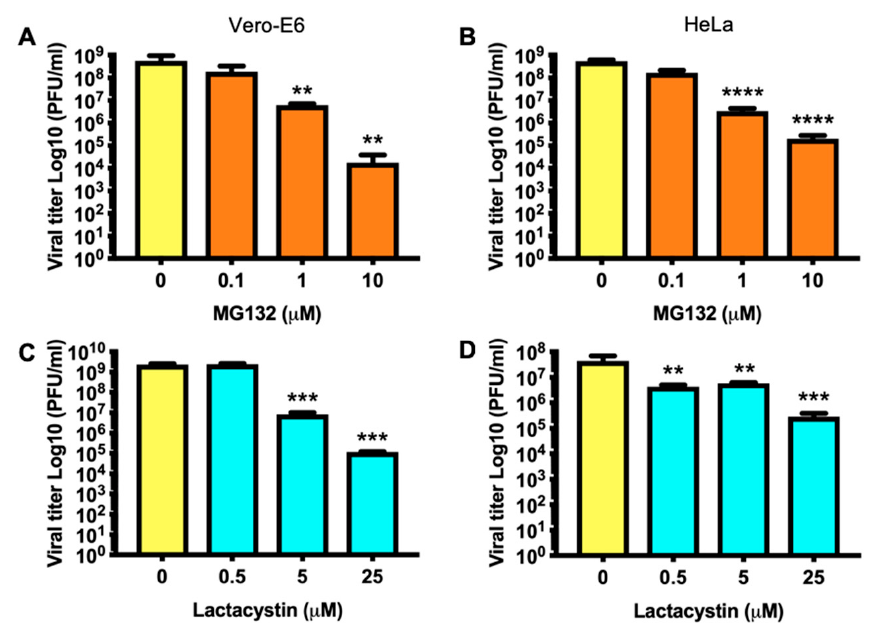
Figure 3. Proteasome inhibitors reduce MAYV progeny production in a concentration-dependent manner. Vero-E6 ( A , C ) or HeLa ( B , D ) cells were pre-treated with the indicated concentrations of proteasome inhibitors. In control cells, DMSO (0.1%) or water was added. At 1 h after treatment, cells were infected with MAYV as described above. Titration of the progeny virus in cell supernatants was carried out by plaque assay. Viral titers were expressed as plaque-forming units per milliliter (PFU/mL). Data were analyzed with the One-way ANOVA test using GraphPad software and are shown as mean ± SD. Statistically significant differences are indicated: ** p < 0.01; *** p < 0.001; **** p < 0.0001.